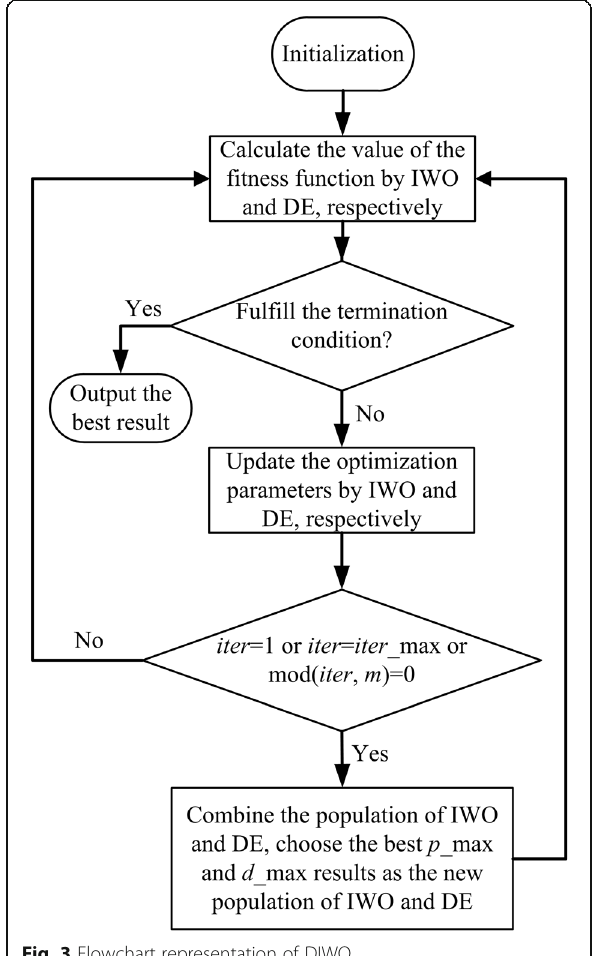
Fig. 3 Flowchart representation of